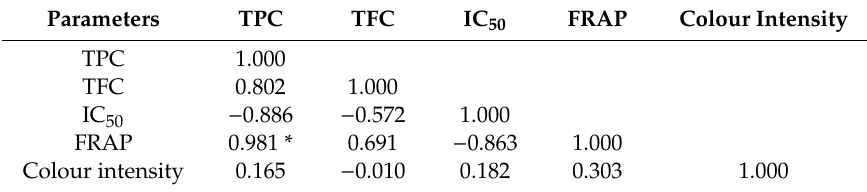
Table 5. Correlation coe ffi cients (r) between antioxidants properties and colour intensity of honey. Parameters TPC TFC IC 50 FRAP Colour Intensity TPC 1.000 TFC 0.802 1.000 IC 50 − 0.886 − 0.572 1.000 FRAP 0.981 * 0.691 − 0.863 1.000 Colour intensity